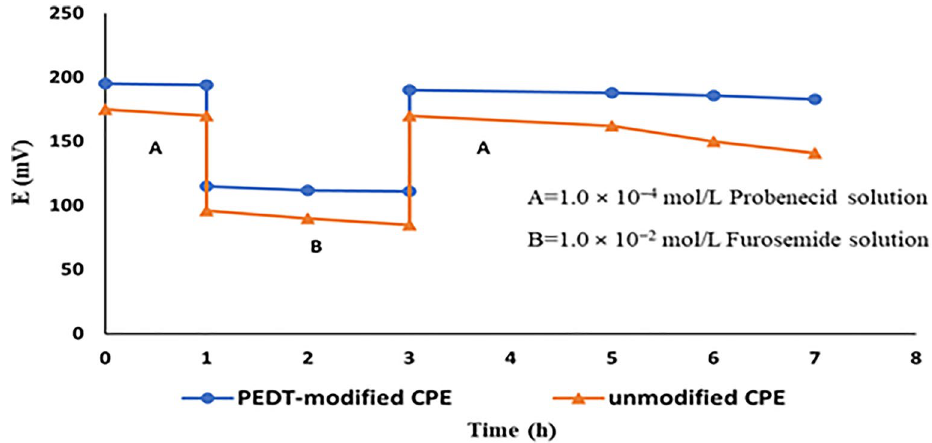
Figure 4. Water layer test for PEDT-modified CPE and unmodified CPE where potential in (mV) was recorded in (A) 1.0 × 10 −4 mol/L probenecid solution and (B) 1.0 × 10 −2 mol/L furosemide solution.